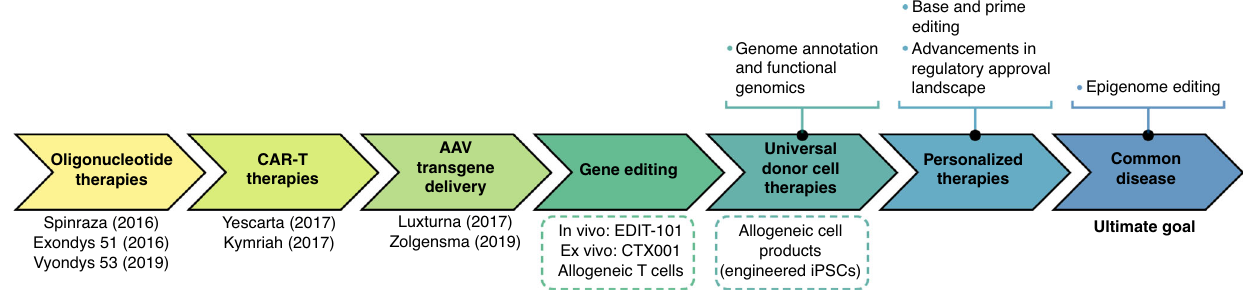
Fig. 1 Timeline depicting milestones (in colored arrows) towards gene therapies for common disease. Approved treatments and year of their approval as well as investigational therapies (in dashed boxes) are shown below each milestone. Further exploration of alternative therapeutic approaches and fundamental scienti fi c questions is still needed to accomplish later milestones (shown in bullets).